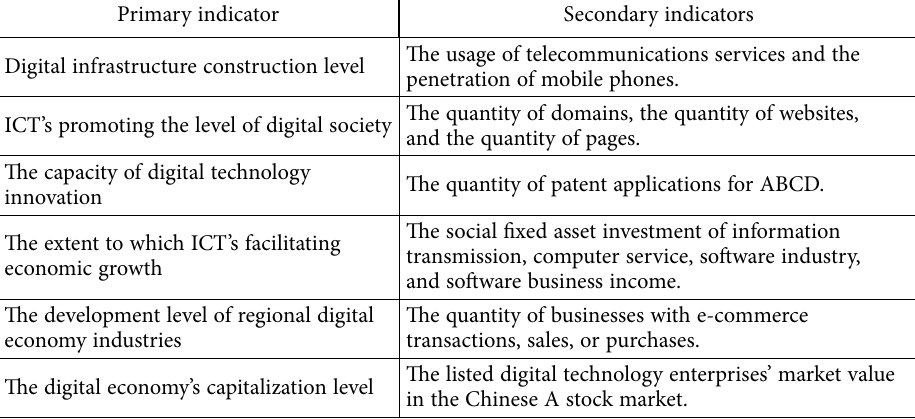
Table 1. Assessment of digital economy development Primary